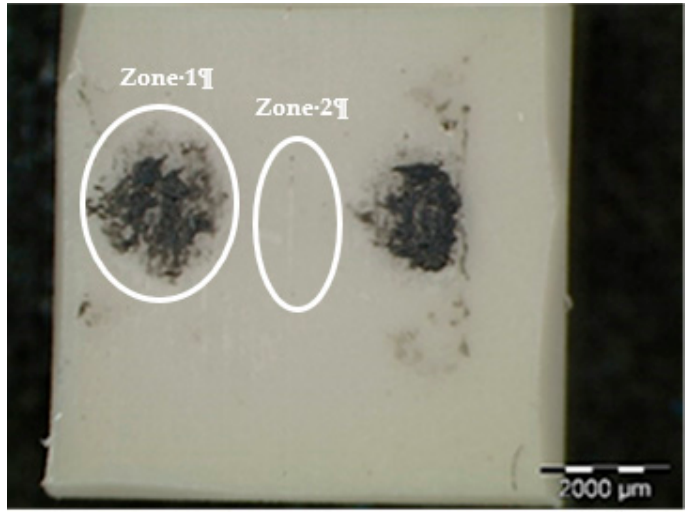
Figure 12. Surface of PA46Z after testing.